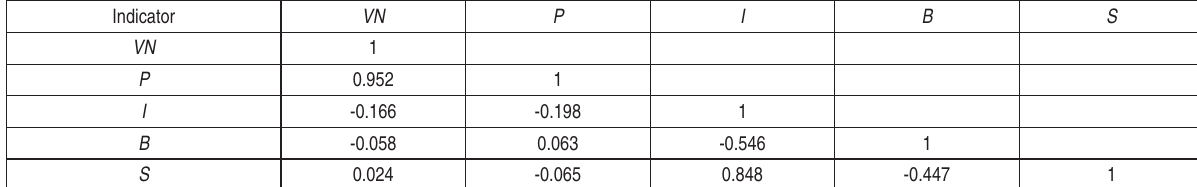
Table 4. Matrix coefficients of pair correlation to calculate the volume of loans to non-bank financial institutions